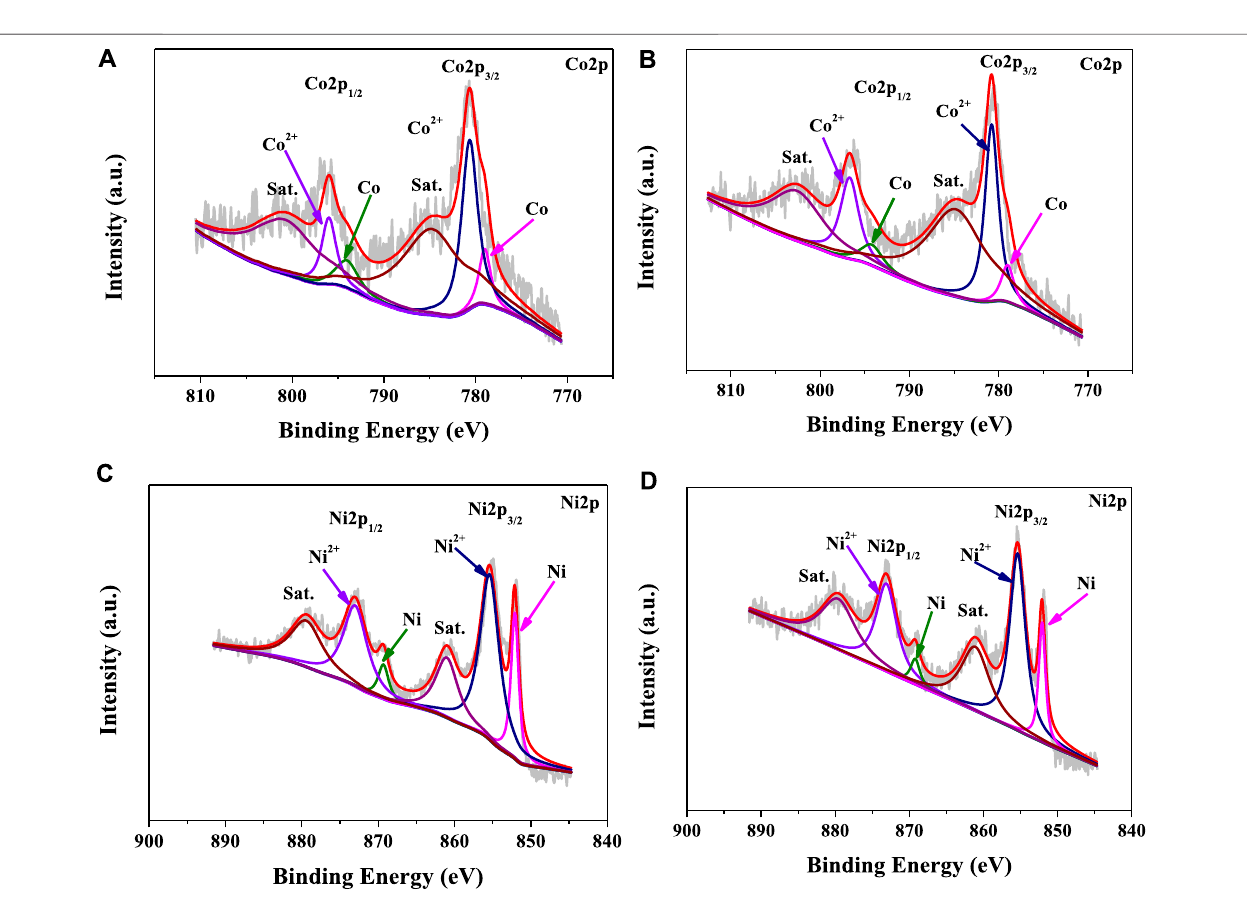
FIGURE 3 | XPS spectra in the Co 2p and Cu 2p regions of the NiCo-1/CF samples before (A,C) and after (B , D) catalytic reactions.